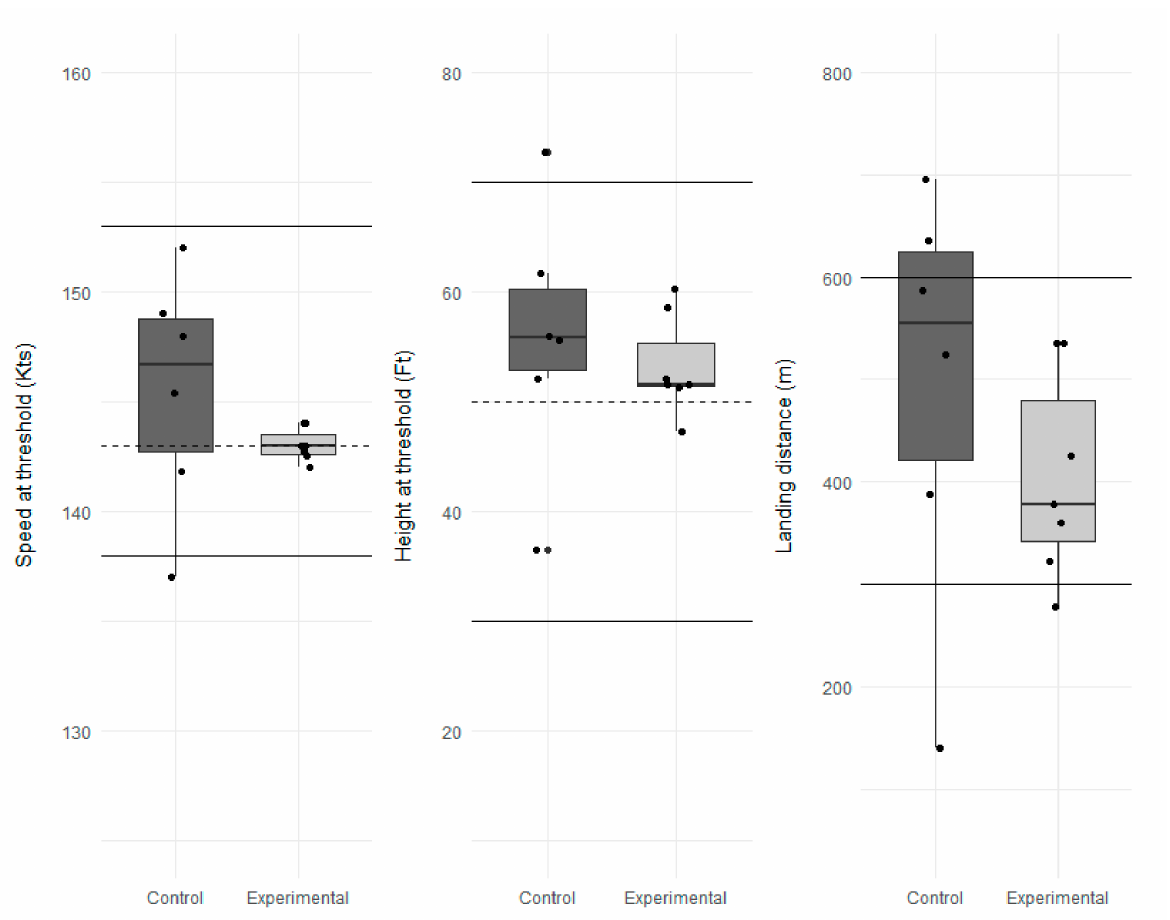
Figure 11. Flight performance during the approach (post-training session). Mean speed, height, and landing distance during landing for the control and experimental groups (dots represent individual data). Solid lines indicate parameter tolerances to meet stabilization criteria. The dashed lines indicate target speed and height. The pilot who did not manage to stabilize the approach has not been included since he aborted the